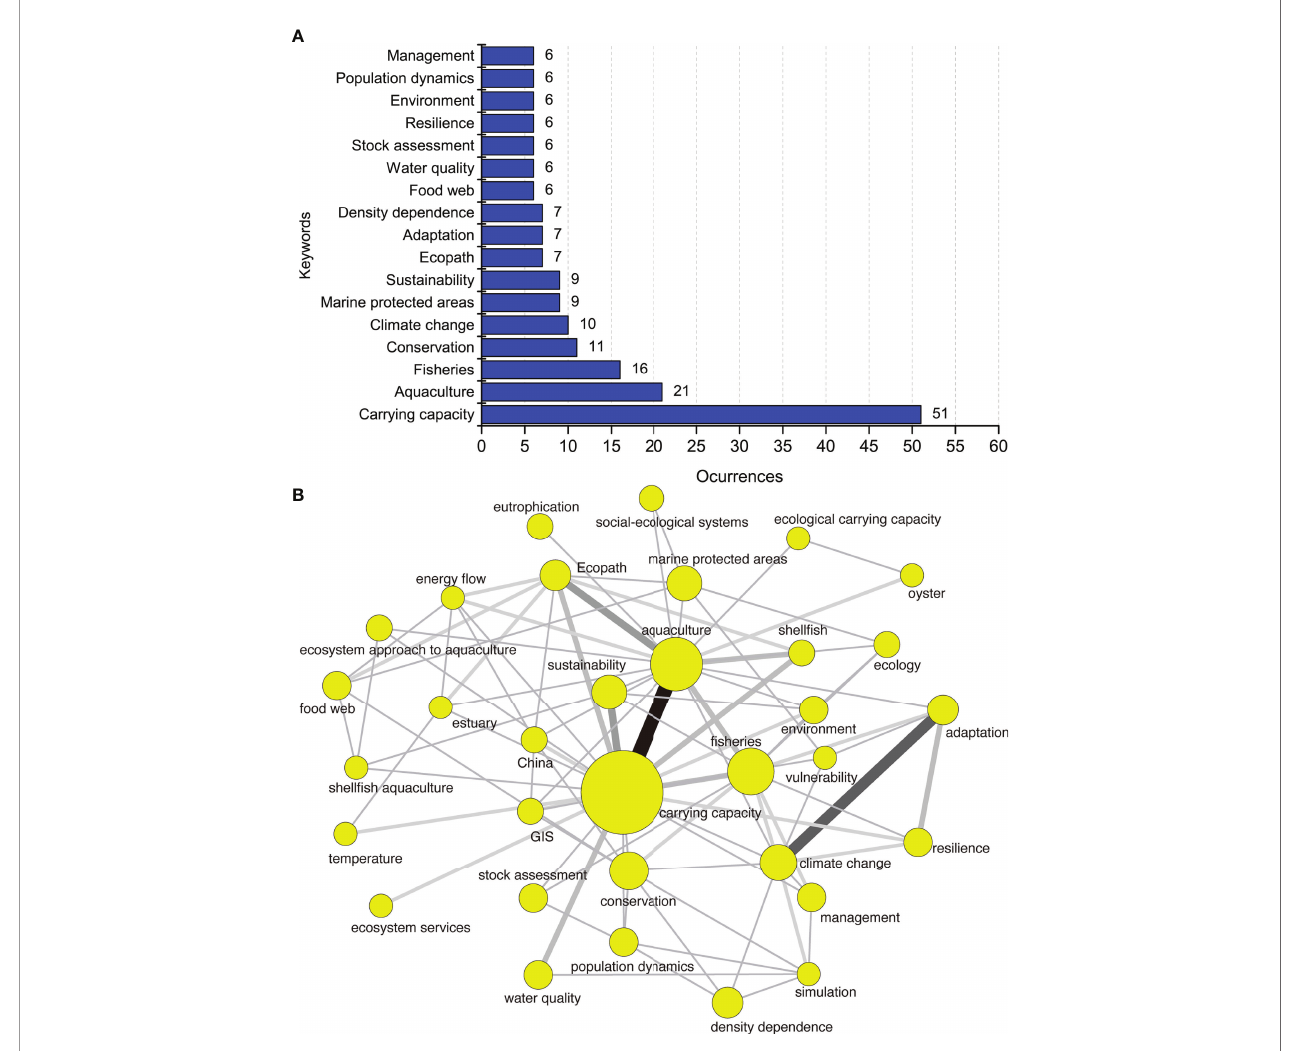
FIGURE 1 | Frequency of top topics related to fi shery resources, ecological environment carrying capacity (A) and keyword co-occurrence network (B)